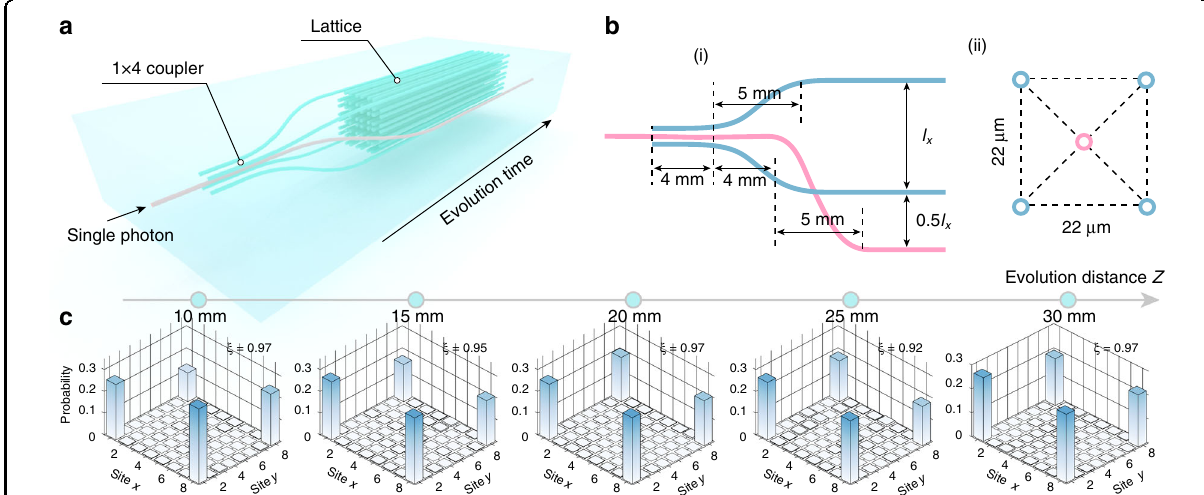
Fig. 3 The 1 × 4 coupler and the measured photon distribution probability of corner states. a Schematic of the photonic lattices. A 1 × 4 coupler is designed before the lattice. b Schematics of the details of the structures of the 1 × 4 coupler of the side section (i) and cross-section (ii). c The experimental results of corner states by exciting the lattices with the photon superposition state. The parameters of C 4 symmetric lattice are ¼ 22 μ m and d i ¼ 9 μ m, ( i = x , y adopted as d i a b